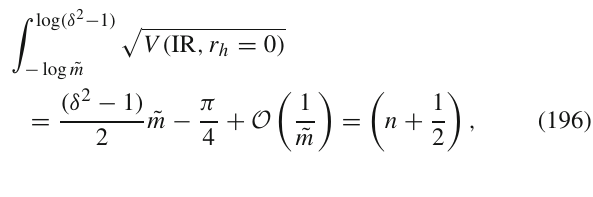
Table1 Summaryofglueballspectra: m = ˜ m r h M-theory using WKB quantization condition for r h (cid:10)= 0, and m = ˜ m r 0 for r h = 0 (equalities in the r h = 0 column, are valid up to NLO in S.